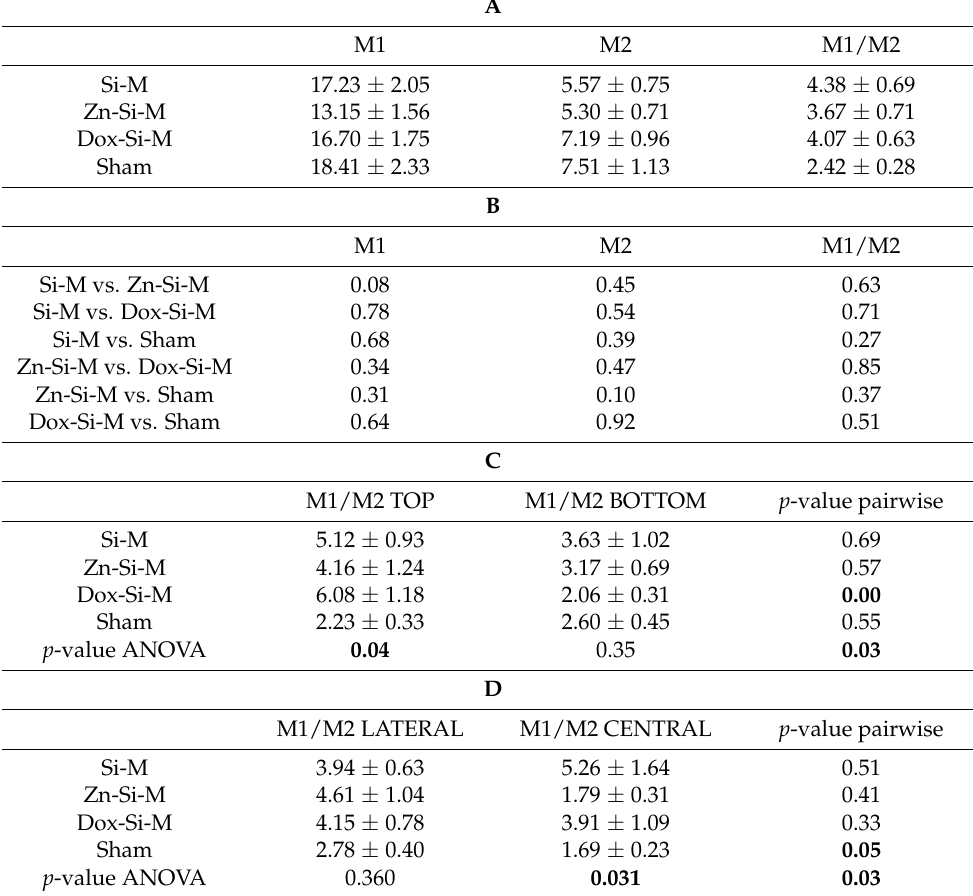
Table 1. (A) Mean ± Standard Error of M1 and M2 macrophage counts in the selected study section. The M1/M2 ratio was also calculated for each studied membrane. (B) Statistical results ( p values) after pairwise comparisons between different membranes. (C) Mean ± Standard Error of M1/M2 macrophage ratio when comparing top (R1, R2, R3) and bottom (R4, R5, R6) regions at the selected study section. (D) Mean ± Standard Error of M1/M2 macrophage ratio when comparing lateral (R1, R3, R4, R6) and central (R2, R5) regions at the selected study section. Bold numbers mean significance at p <